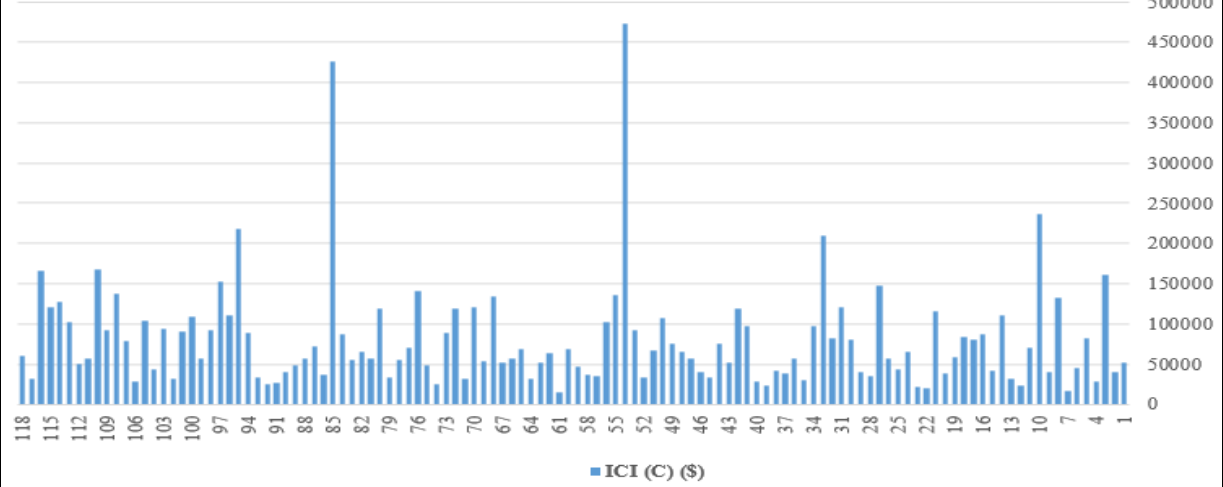
Figure 3: The costs (energy stream) of ICI.